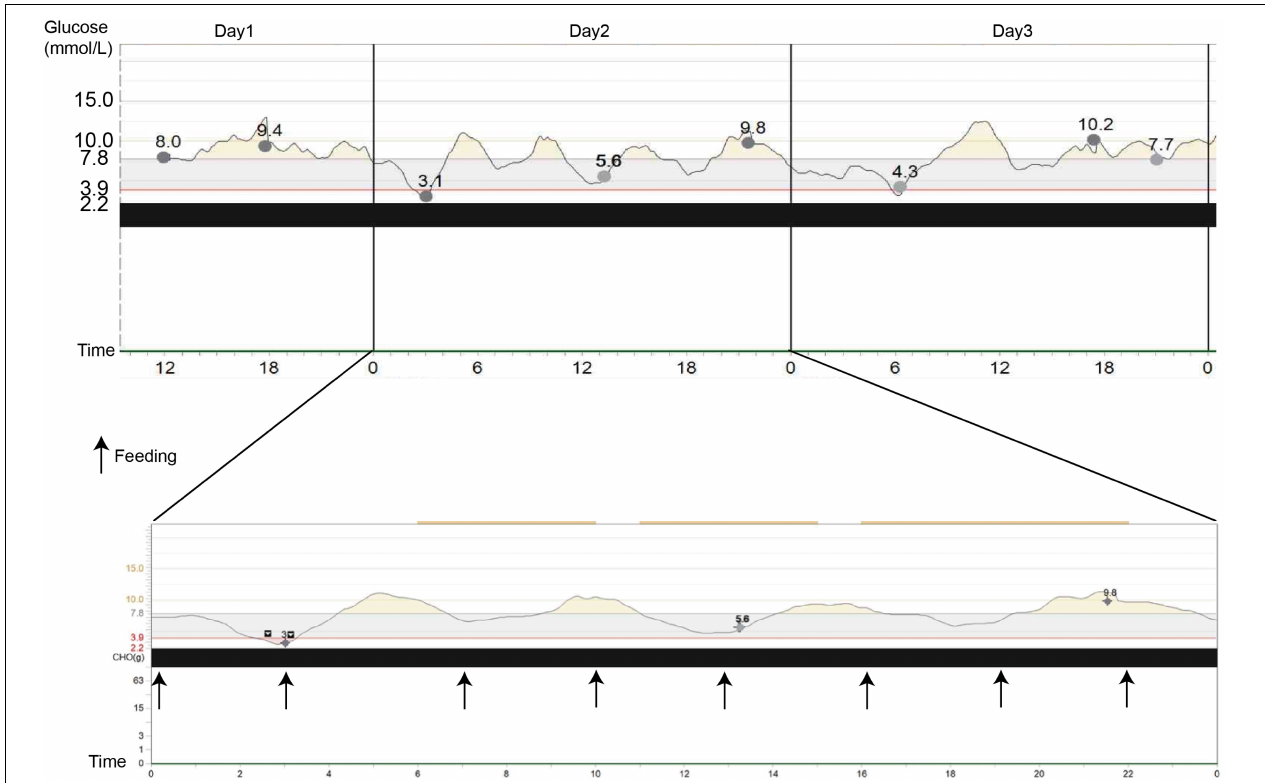
FIGURE 2 | Continuous glucose monitoring system (CGMS) at diagnosis. The patient presented postprandial hyperglycemia, and when she fasted, a tendency to hypoglycemia, followed by marked hyperglycemia, can be observed. Black arrows represent the